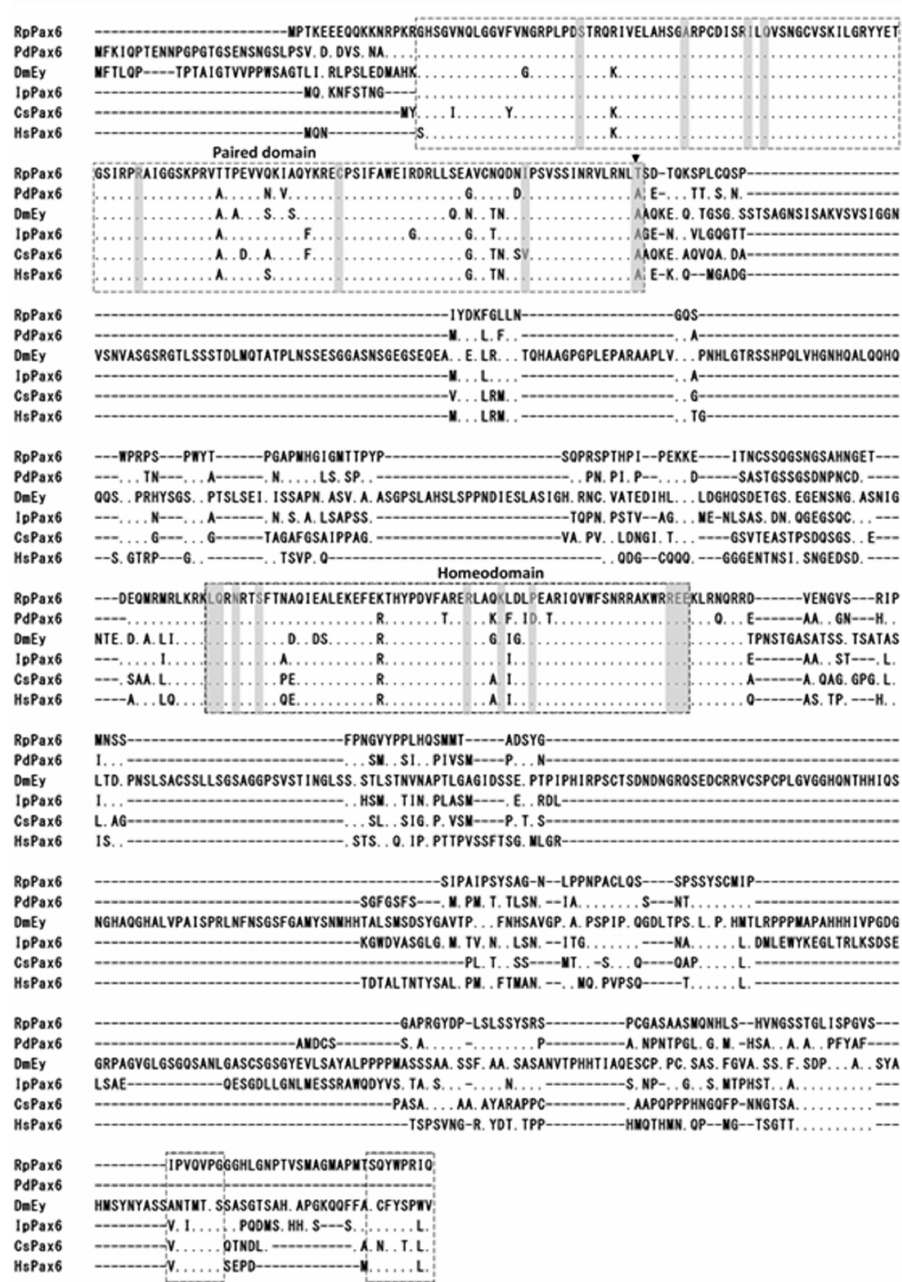
Fig 1. Comparison of amino acid sequences of Pax6 genes. Identical amino acids are indicatedby dots. The introducedgaps are indicatedby dashes. The paireddomain, homeodomain and conservedC-terminal motif are boxed. Pax6-specific amino acids [5] are shaded.Arrowheadindicatesa singleamino acid change of the Pax6-specific amino